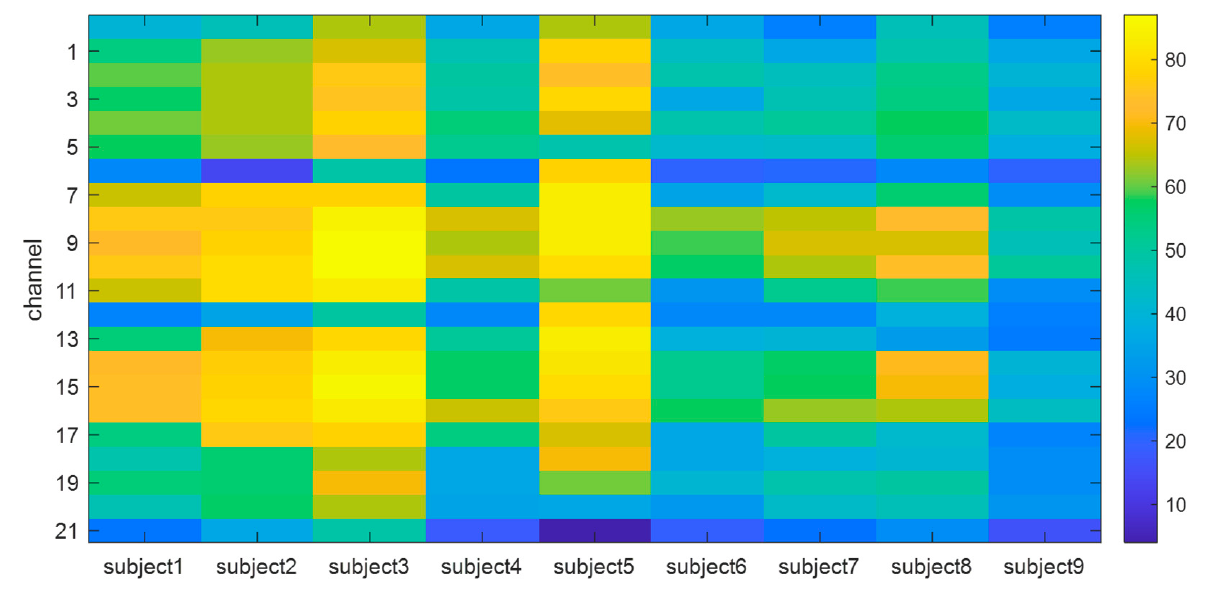
Figure 9. Cumulative channel correlation heatmap by subject. The heatmap is based on the cumu- lative value of the number of times the correlation between channels is greater than 0.8.